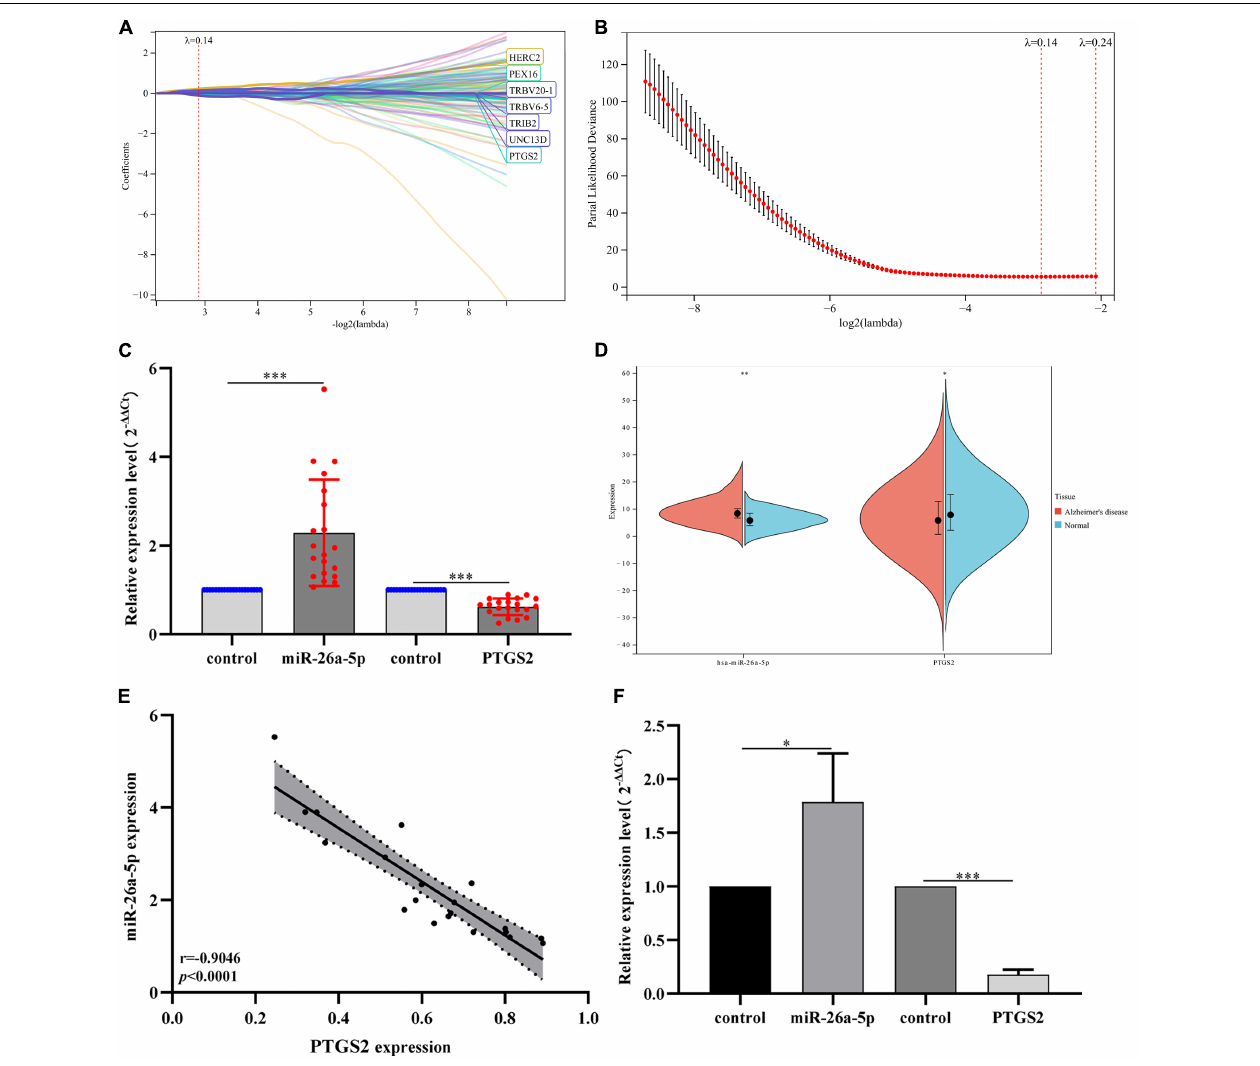
FIGURE 5 | (A) LASSO coefficient profiles of 7 AD characteristic genes in the GSE85426 dataset. (B) Plot of partial likelihood deviance. (C) The expression levels of miR-26a-5p and PTGS2 in peripheral blood of AD patients (20 AD patients and 20 control samples). The expression level of GAPDH was used as an internal reference for PTGS2 and U6 for miR-26a-5p. The data are shown as the mean ± standard deviation. (D) The expression levels of miR-26a-5p and PTGS2 in the merged dataset (GSE140829 and GSE97760). (E) Correlation analysis of the expression of miR-26a-5p and PTGS2 in peripheral blood of AD patients (20 AD patients and 20 control samples). (F) The expression levels of miR-26a-5p and PTGS2 in AD model cells (A β 25 − 35 -treated SH-SY5Y cells). The expression level of GAPDH was used as an internal reference for PTGS2 and U6 for miR-26a-5p. The data are shown as the mean ± standard deviation. AD, Alzheimer’s disease. ∗∗∗ p < 0.001; ∗∗ p < 0.01; ∗ p <